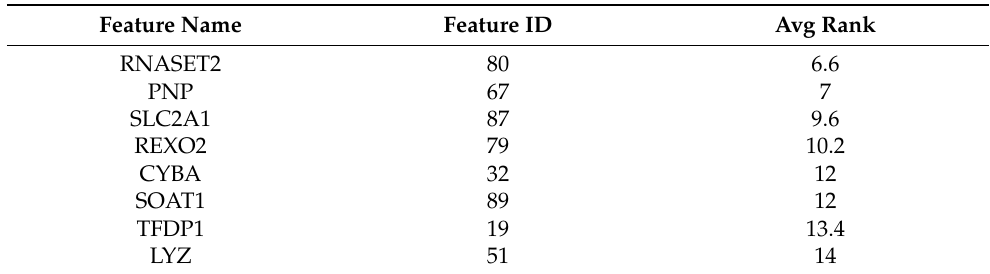
Figure 6. Least-Absolute Shrinkage and Selection Operator (LASSO) logistic regression and the Support Vector Machine (SVM) algorithm were utilized to screen key genes. ( A , B ) PNP and SLC2A1 were identified with LASSO; ( C ) RNASET2, PNP, SLC2A1, REXO2, CYBA, SOAT1, TFDP1, and LYZ were identified using SVM; ( D ) PNP and SLC2A1 were identified in the results of both LASSO and SVM. Table 2. Eight candidate genes (RNASET2, PNP, SLC2A1, REXO2, CYBA, SOAT1, TFDP1, and LYZ) screened via Support Vector Machine